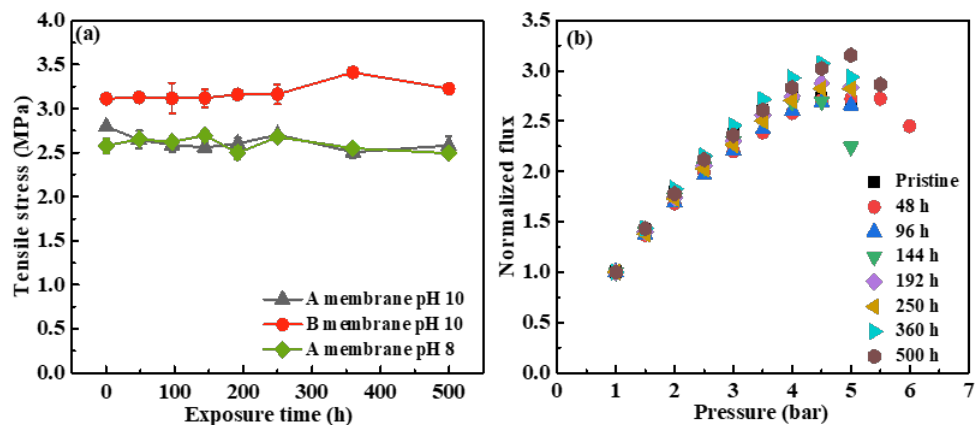
Figure 4. Changes in membrane mechanical properties with NaOCl exposure time. ( a ) Changes in the tensile stress of A and B membranes with NaOCl exposure time; and ( b ) changes in the collapse pressure of the C membrane with NaOCl exposure time.